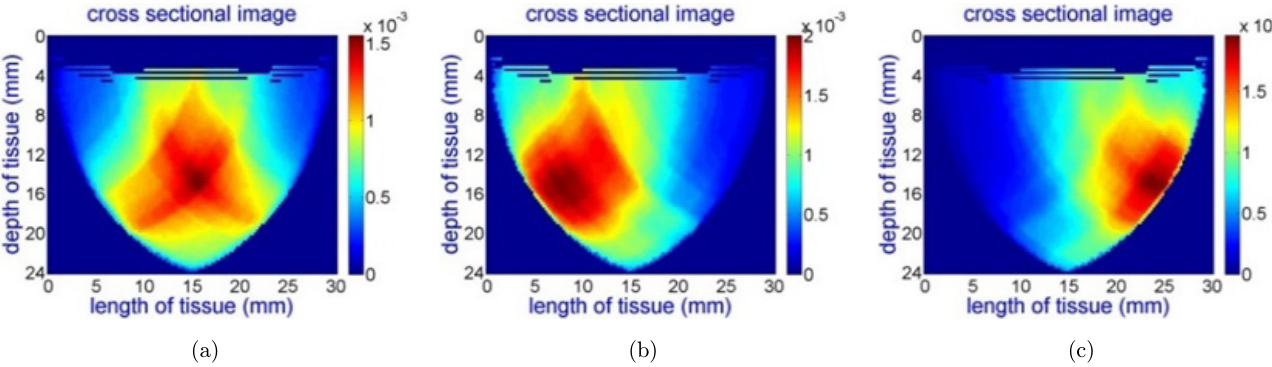
Fig. 6. Reconstructed cross-sectional images of the phantom for the wavelength of 690 nm while the center line of the probe is aligned: (a) with the center of the hole, (b) 7 mm left to the hole, (c) 7 mm right to the hole.